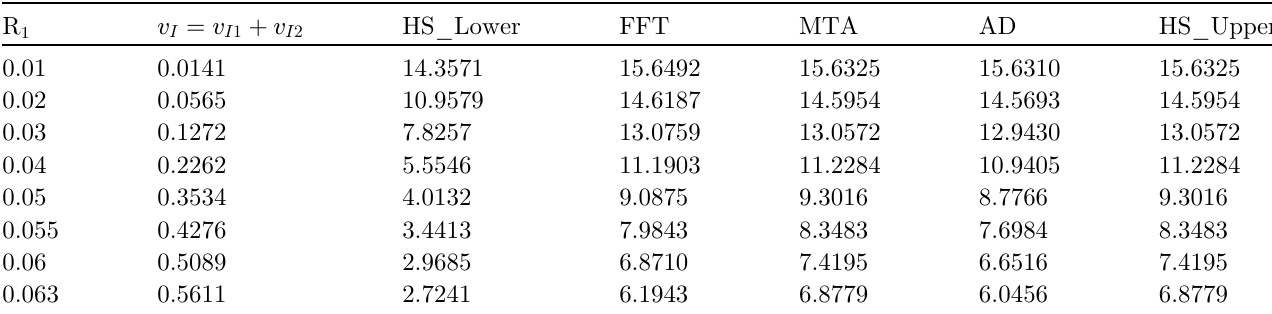
ffiffiffi p R 2 2 .